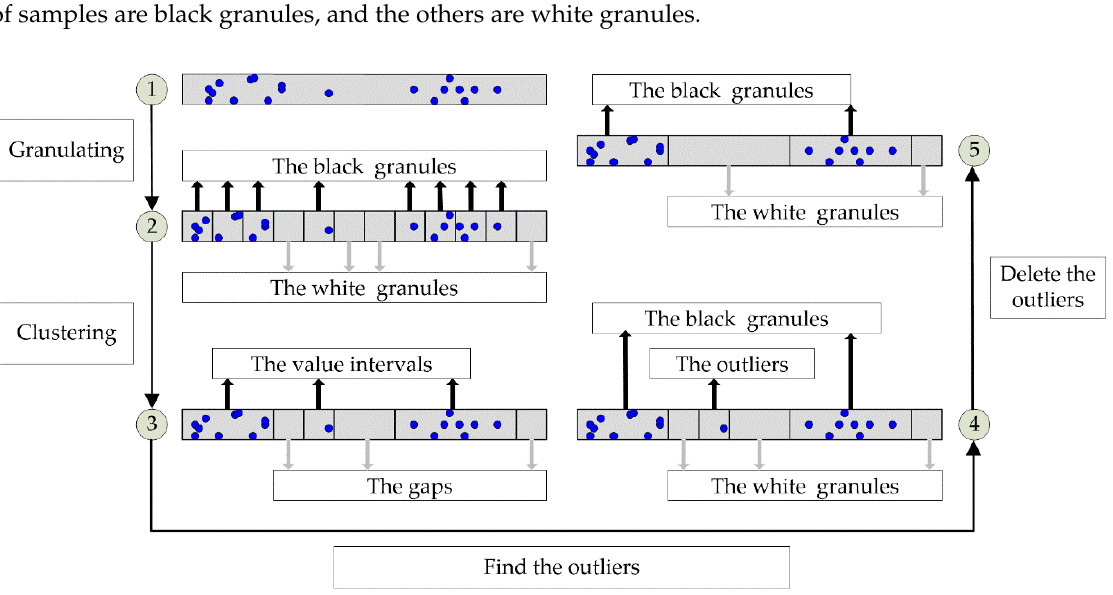
Figure 3. Information granulation and neighboring clustering.